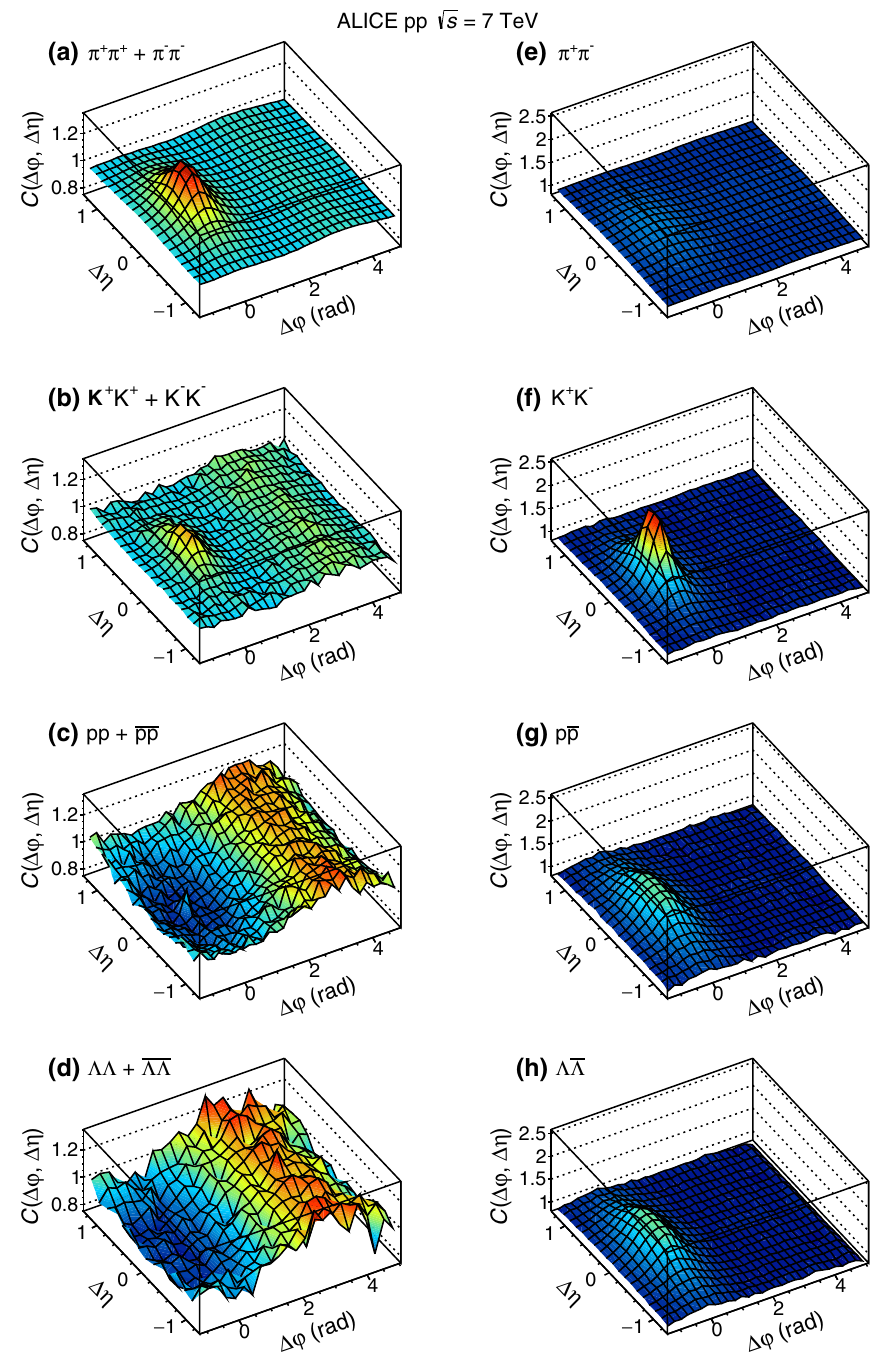
Fig. 1 Correlation